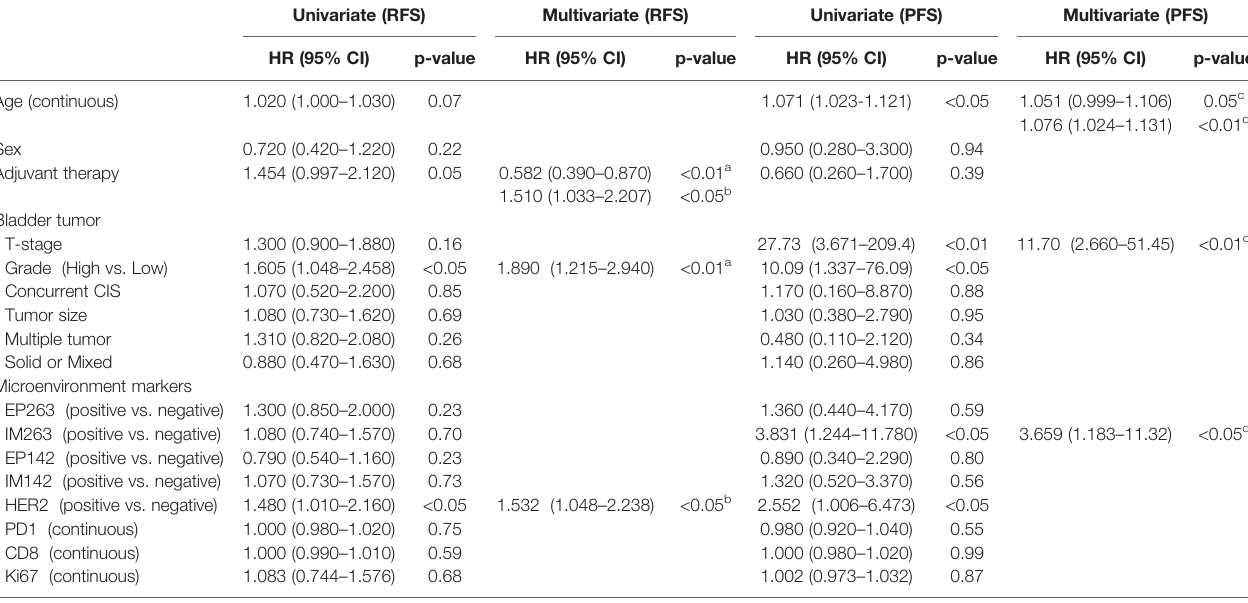
TABLE 3 | Univariate and multivariate analyses of RFS and PFS in NMIBC